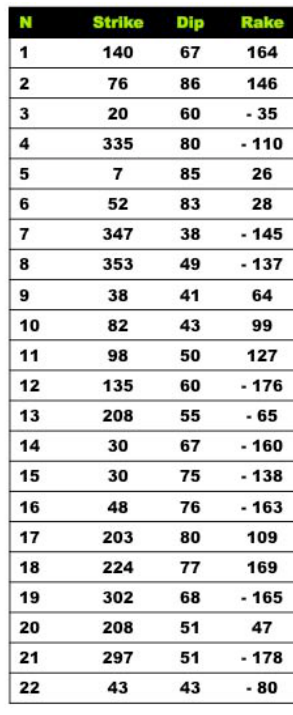
Fig. 3. Moment Tensors and correspondent Strike, Dip and Rake angles in the Messina Strait Area listed in the relative Table.